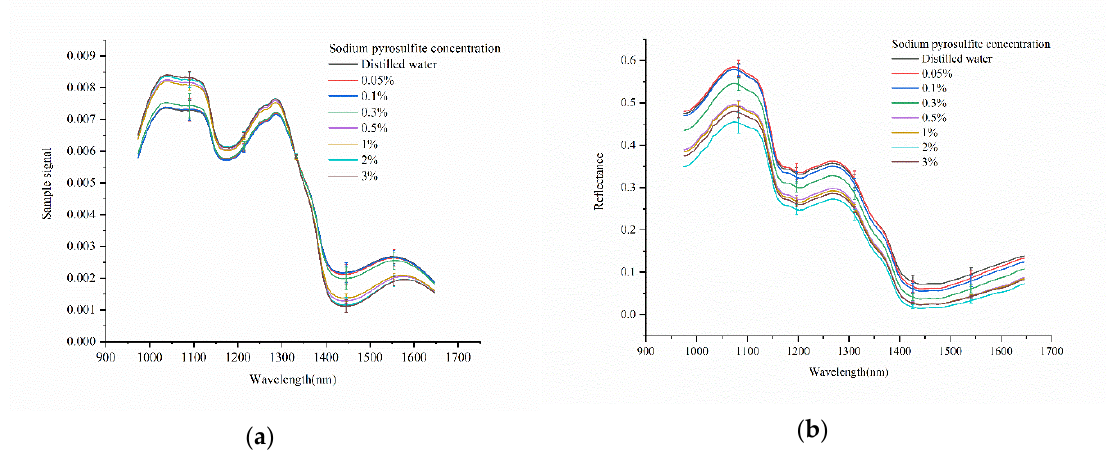
Figure 1. The average spectra with standard deviation of fresh-cut potato slices immersed in different sodium pyrosulfite solution collected by ( a ) portable NIR spectrometer and ( b ) NIR-HSI system.